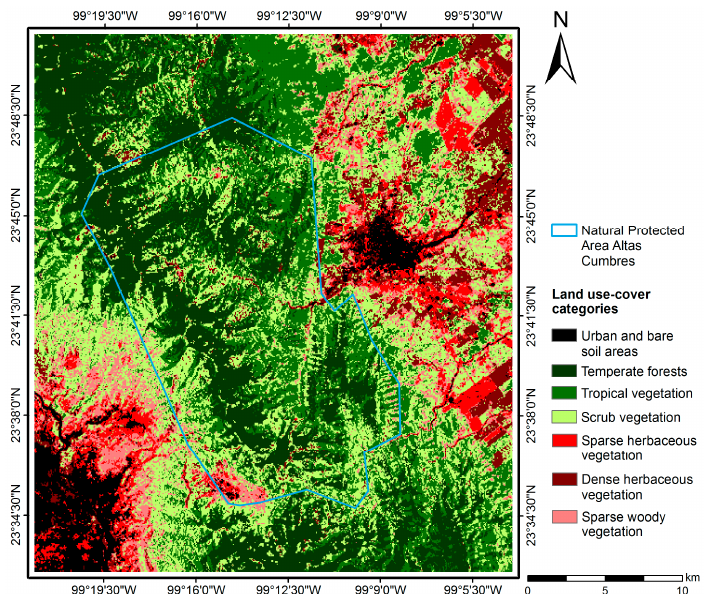
Figure A1. Land use-cover in 1973, Natural Protected Area Altas Cumbres and adjacent area. Victoria, Tamaulipas, Mexico.